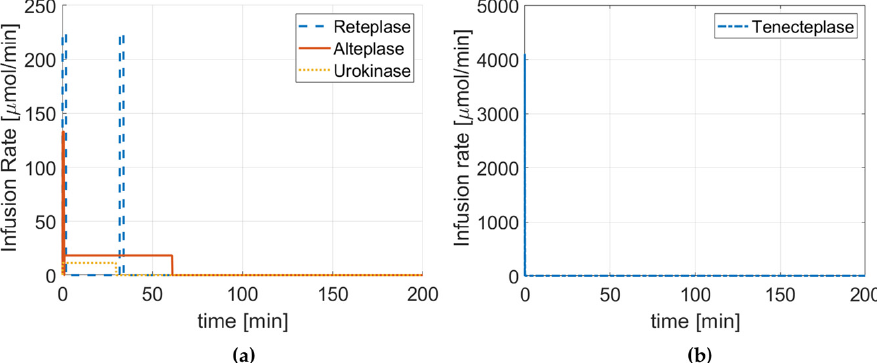
Figure 2. Intravenous dose regimen for ( a ) reteplase, alteplase, and urokinase, and ( b ) tenecteplase.